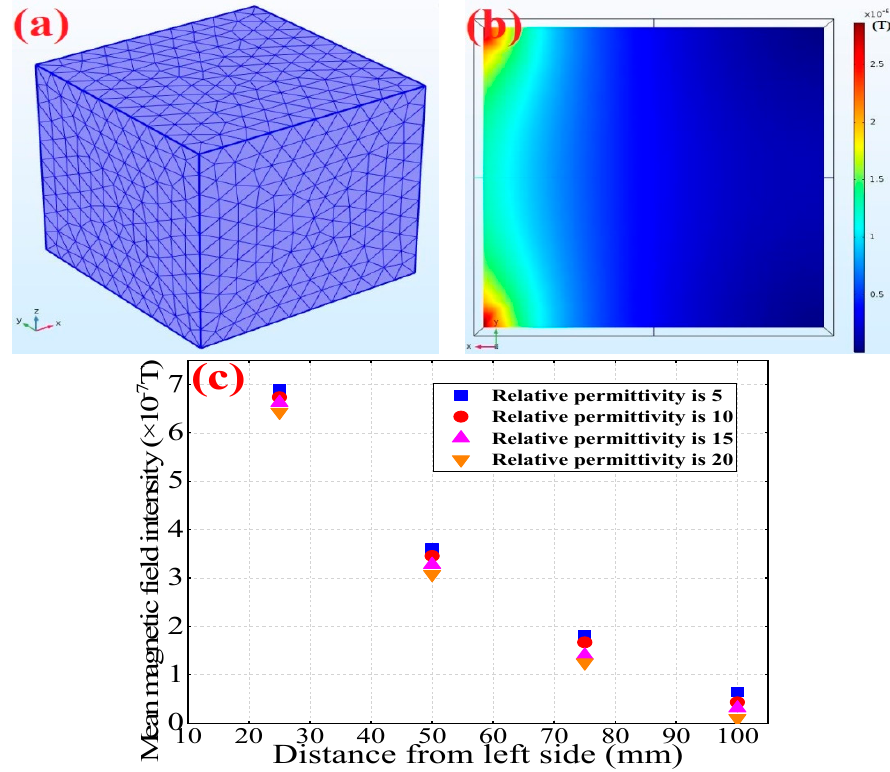
Figure 1. Simulation model establishment and analysis: ( a ) grid division, ( b ) magnetic field intensity distribution, ( c ) the relationship between magnetic field intensity and distance from the left side of the concrete specimen.